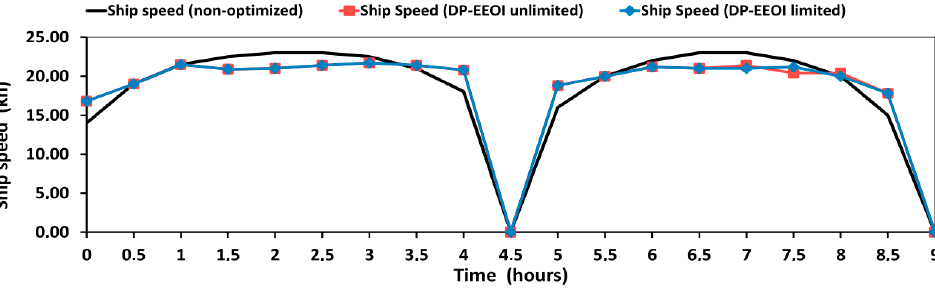
Figure 9. Ship speed (kn): DP with/without EEOI limitation.